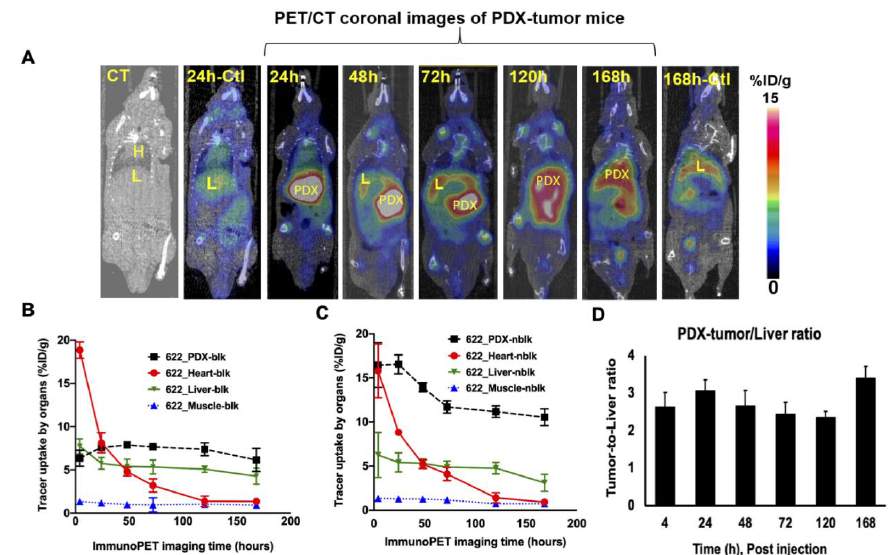
Figure 3. PET/CT coronal images of 89 Zr-Df-H3K3 in PDX-NSG and control mice. ( A ) PET/CT coronal images from PDX-NSG at various time points (24, 48, 120, 72, and 168 h p.i.) after administration of 89 Zr-Df-H3K3. PET/CT or CT images of control group are also shown (at 24 h and 168 h p.i.) for comparison. Data were computed as mean ± SD %ID/g ( n = 4) from ROI of non-tumor bearing liver from control group. ( B , C ) Time-activity curves of 89 Zr-Df-H3K3 uptake into the PDX, heart, liver and muscle in the ( B ) blocking and ( C ) non-blocking mice groups were computed as ROI from the PET images. ( D ) PDX-to-liver ratio of non-blocking mice at various time points were computed from ROI data. Tracer uptake are decay corrected and presented as mean ± SD %ID/g.